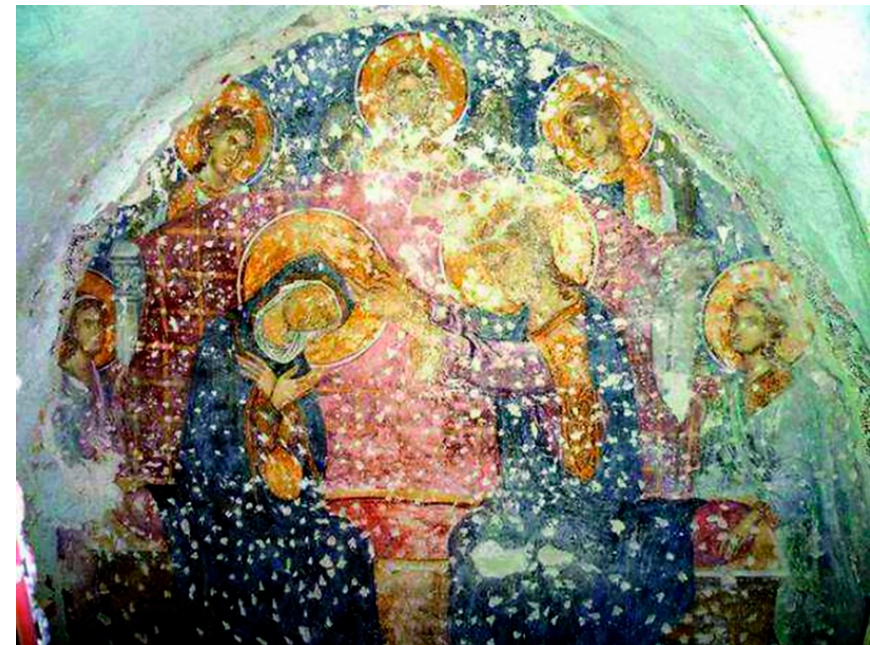
Figure 11. Pera, the church of St. Paul, south chapel (perhaps of the Virgin Mary and of the De Via family), upper part of the east wall, scene of the Coronation of the Virgin (mid-14th century?); after Rönesans (2012, pp. 36–37).